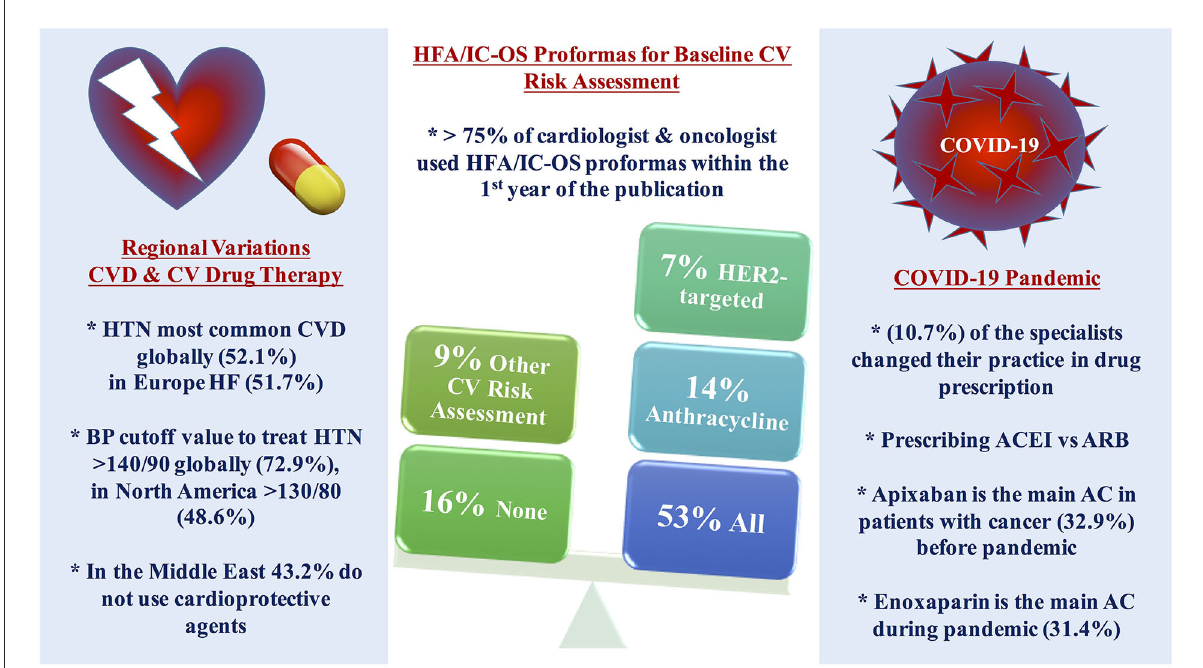
FIGURE1 Central illustration of the main results. More than three-quarters of the cardiologists and oncologists are using HFA/IC-OS proformas for baseline CV risk stratification among patients with cancer, more than half of the respondents use all the proformas, while using only one proforma was found mainly with anthracycline followed by HER2-targeted therapy with the limited use of other proformas. Regional variations were found in the pattern of the main baseline CVD and CV management among patients with cancer in different continents. The use of cardioprotective agents is limited in the Middle East. COVID-19 pandemic impacted on the decision of selection between CV drug therapy and anticoagulant. AC, anticoagulant; ACEI, angiotensin-converting enzyme inhibitor; ARB, angiotensin receptor blocker; CV, cardiovascular; CVD, cardiovascular disease; HF, heart failure; HFA/IC-OS, Heart Failure Association/International Society of Cardio-Oncology; HTN, hypertension; LMWH, low molecular weight